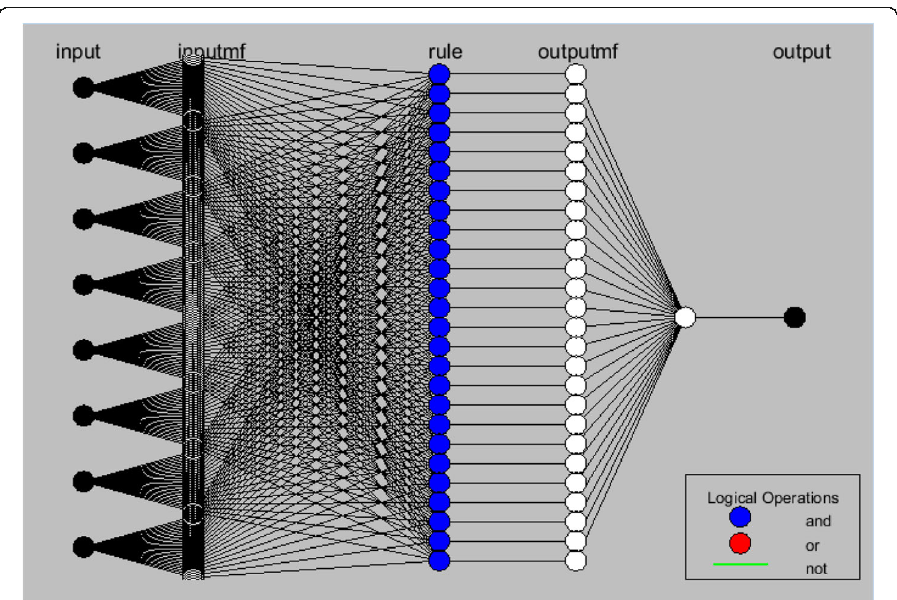
was reduced to less than 80 repetitions, after which no significant change was observed.